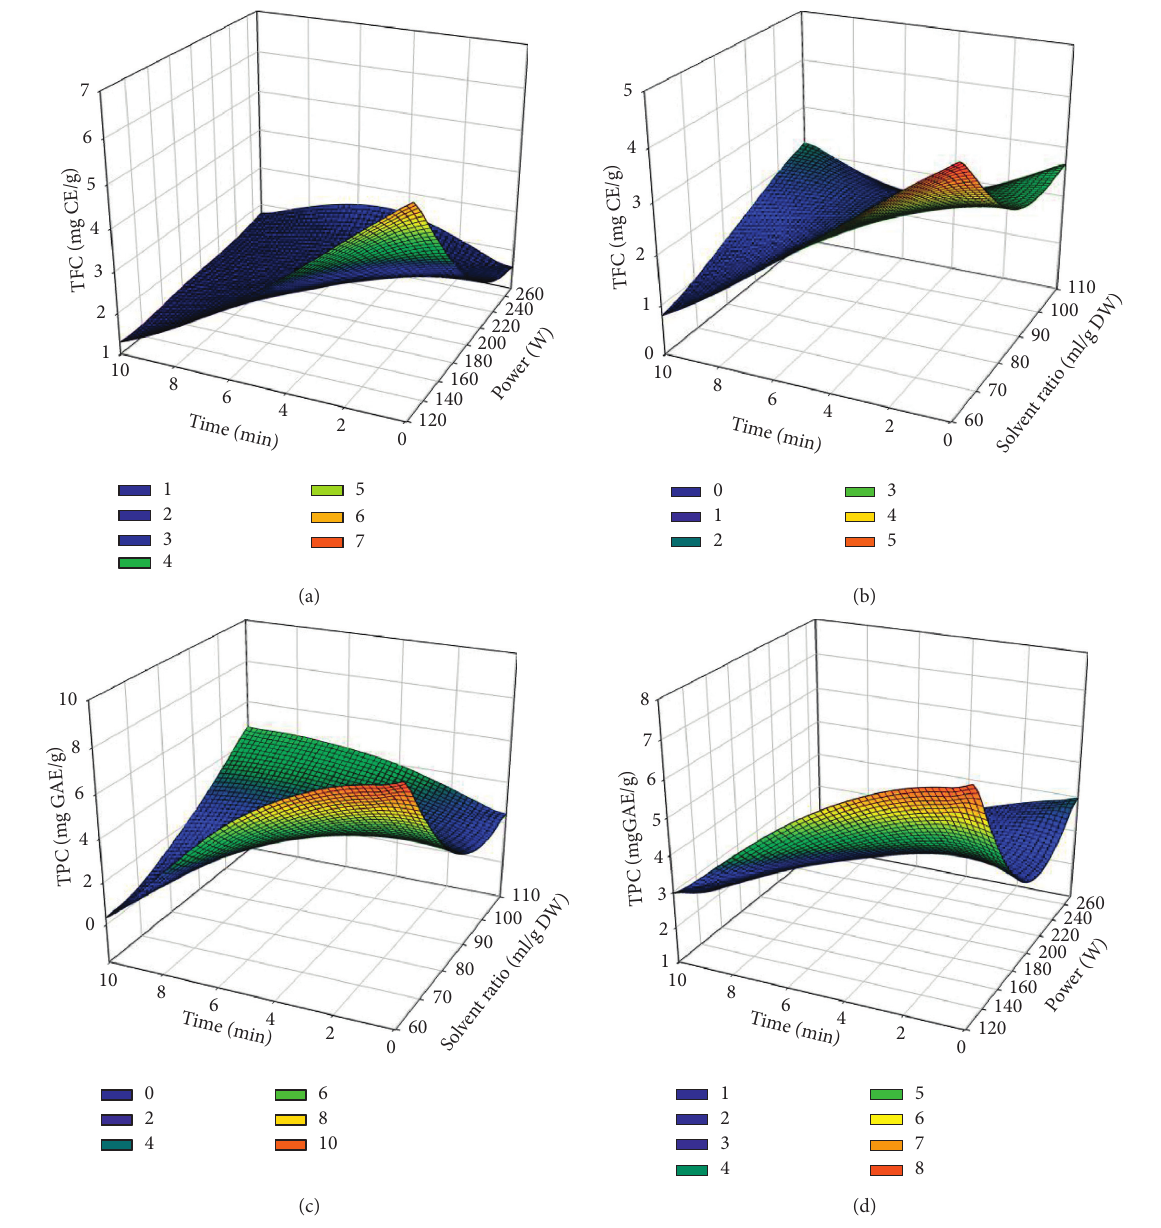
Figure 4: (a, b, c, and d) Response surface curves for TPC and TFC considering the different factors taken 2 by